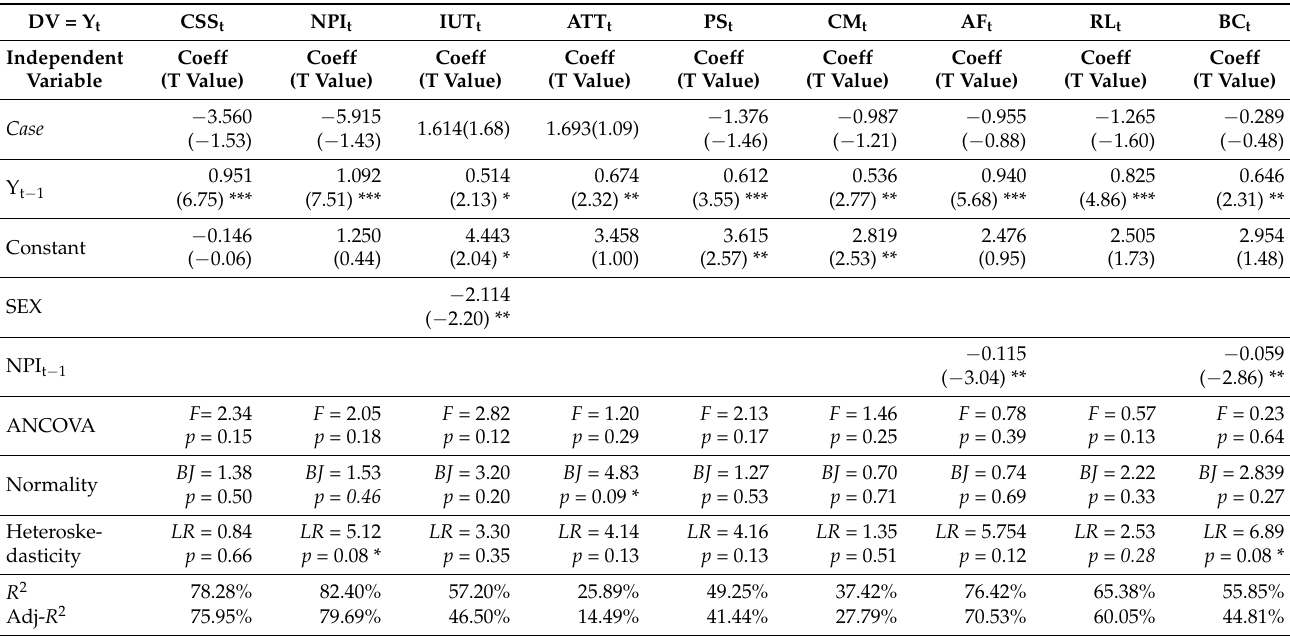
Table 4. Results for the ANCOVA